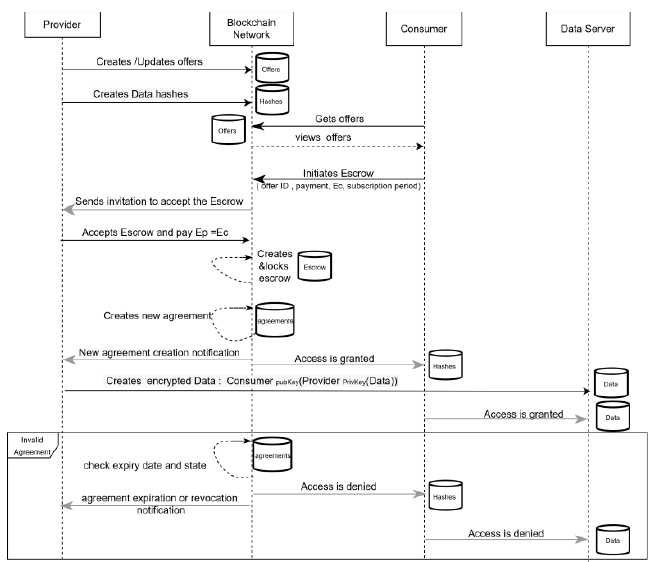
Figure 4: Data access agreement sequence